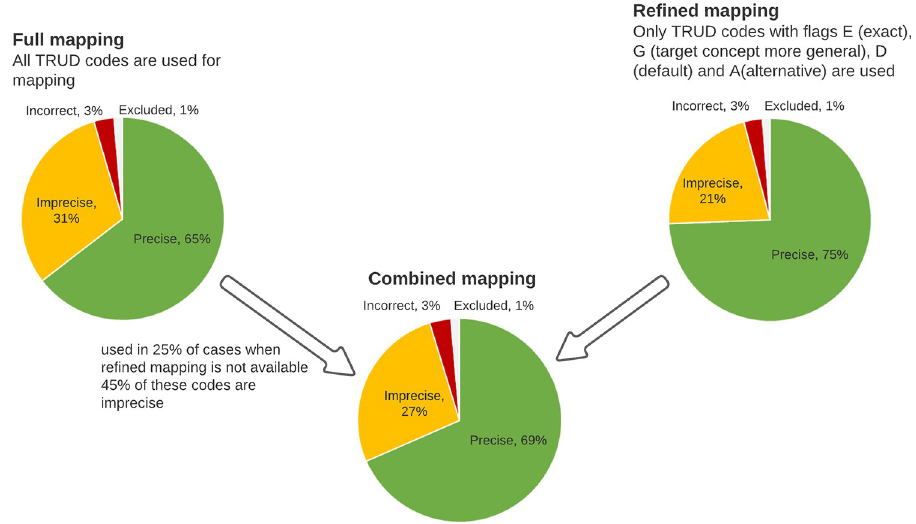
Fig 3. Workflow for using TRUD flags to refine automated mapping from Read codes to ICD10.